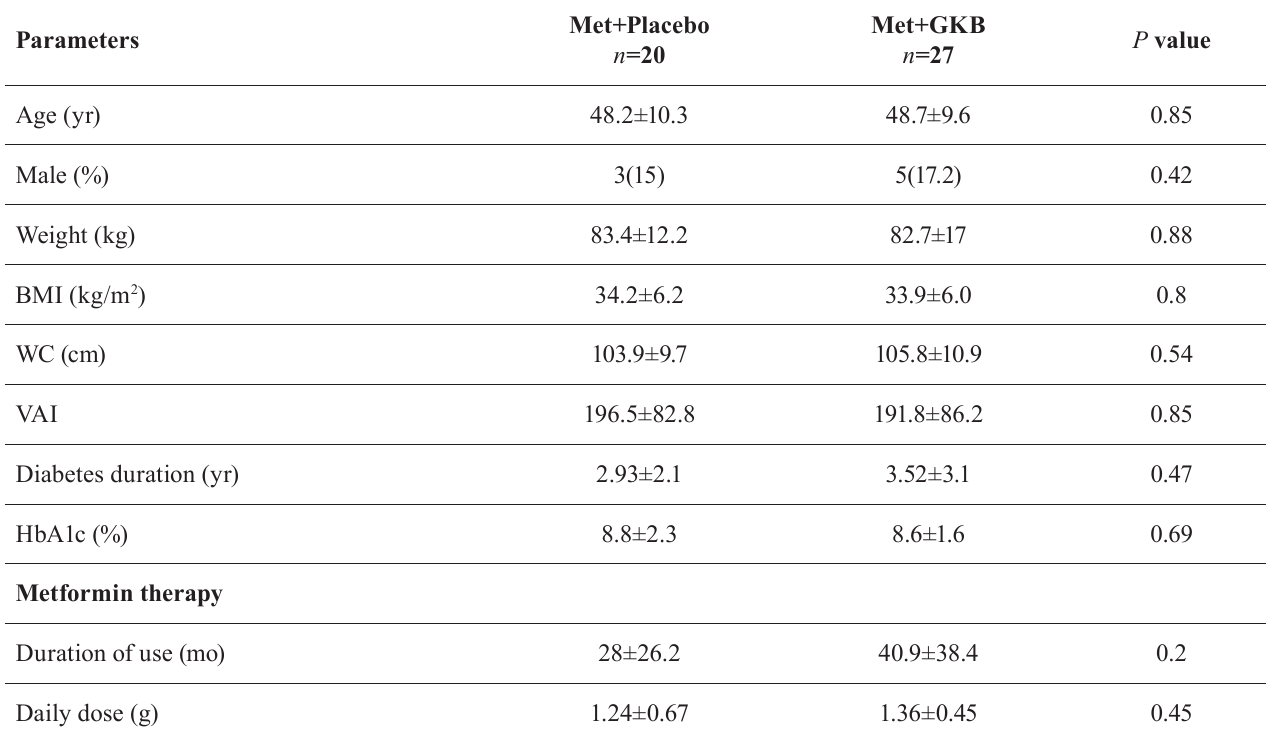
TABLE I - B aseline characteristics of the T2DM patients enrolled in the study